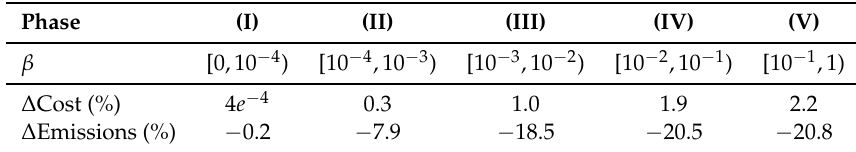
Table 1. The average changes in cost and emissions in different β periods. The change is compared to pure economic optimization (i.e., β =